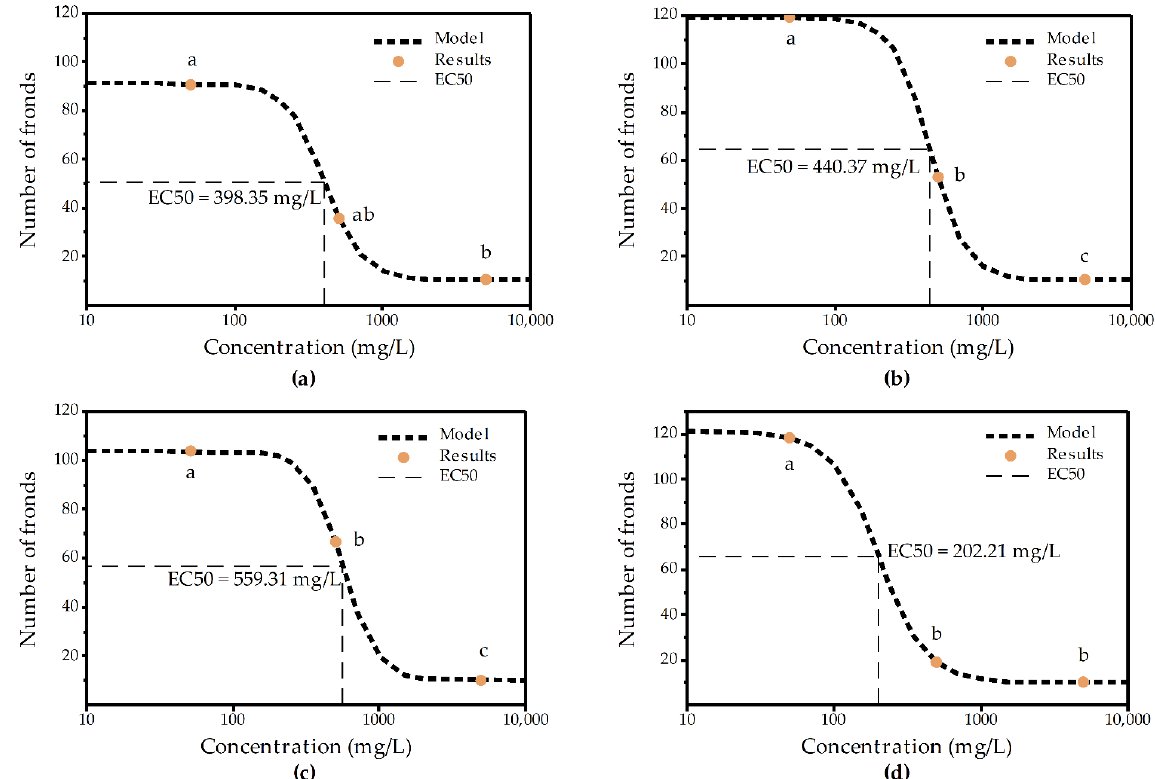
Figure 2. Dose–response curve of the number of fronds and the concentrations of ( a ) chitosan with low molecular weight (ChiS), ( b ) chitosan with medium molecular weight (ChiM), ( c ) chitosan with high molecular weight (ChiL) and ( d ) chitosan with a deacetylation degree of approximately 50% (Chi50). Symbols with same letter do not present statistically significant differences (Supplementary Tables S4 and S5).